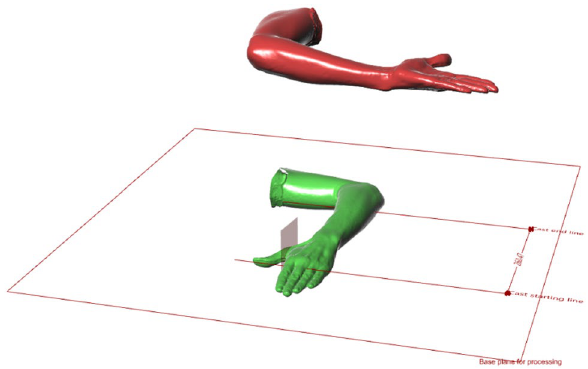
Fig. 5 Preorientation Rhinoceros panel: On upper side (in red) the original mesh of the forearm randomly oriented; on lower side (in green) the mesh oriented and the referenced XY plane